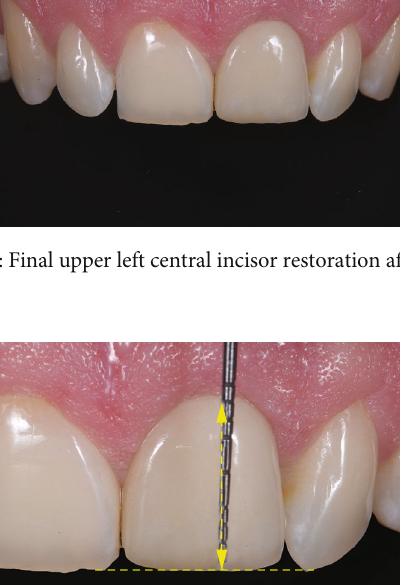
Figure 18: BBT measurement at the upper 5 mm of the implant on a CBCT scan at